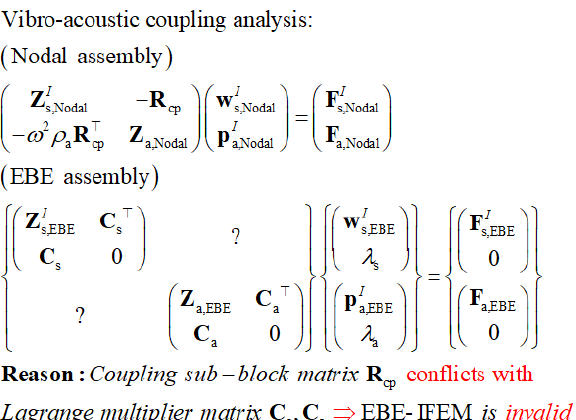
Figure 2. The failure reason for EBE-IFEM to analyze the vibro-acoustic coupling